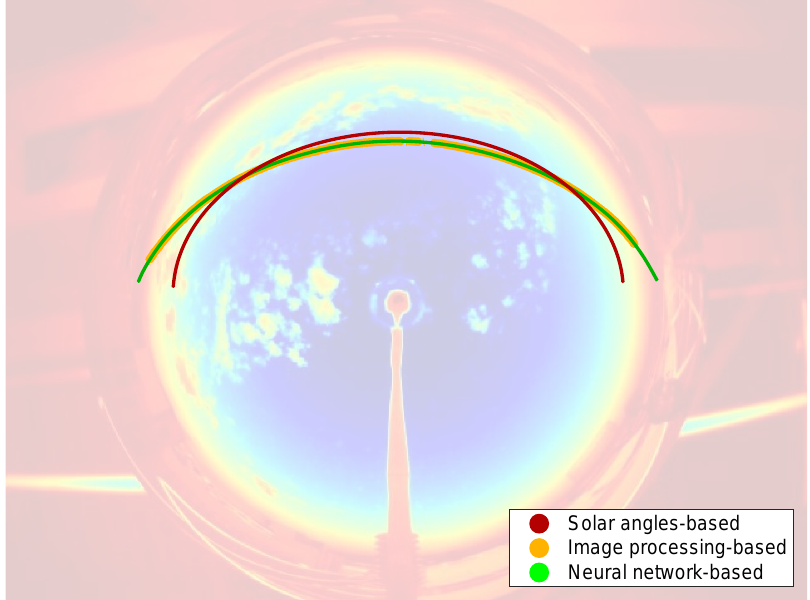
Figure 14. Trajectories identified by the three